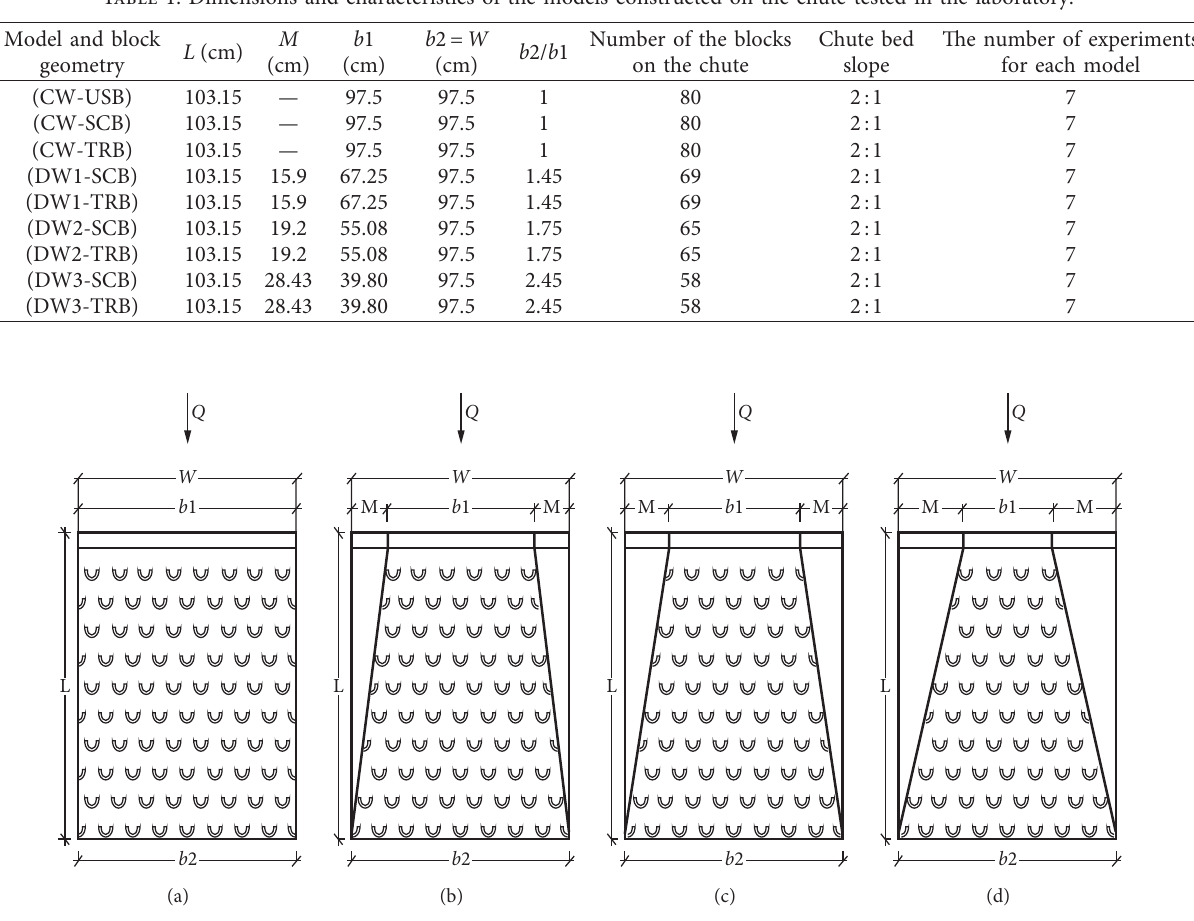
Figure 5: The plan and dimensions of the chute with different opening ratios and semicircular blocks: (a) b 2/ b 1 � 1, (b) b 2/ b 1 � 1.45, (c) b 2/ b 1 � 1.75, and (d) b 2/ b 1 � 2.45.